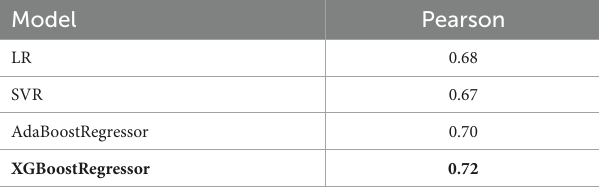
TABLE 3 Examples of retain SC-LIWC